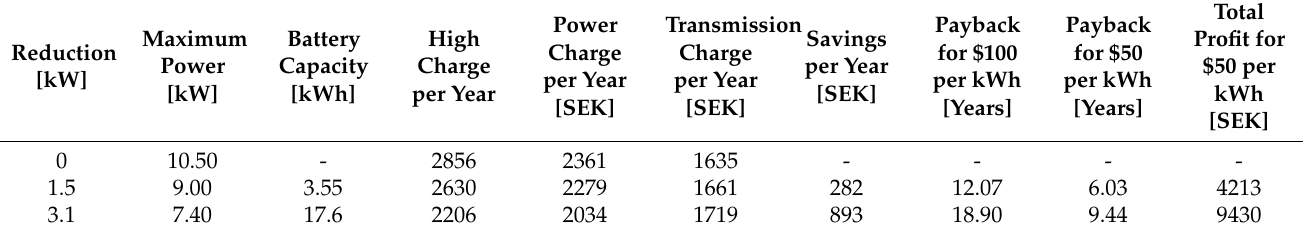
Table 3. Economic calculations before and after reduction of the power peak for high power houses.